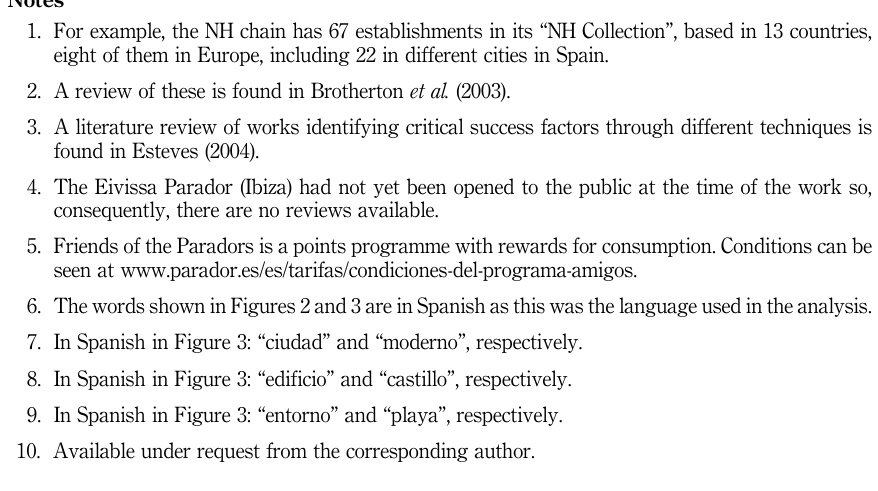
8. In Spanish in Figure 3: “ edificio ” and “ castillo ” , respectively. 9. In Spanish in Figure 3: “ entorno ” and “ playa ” ,